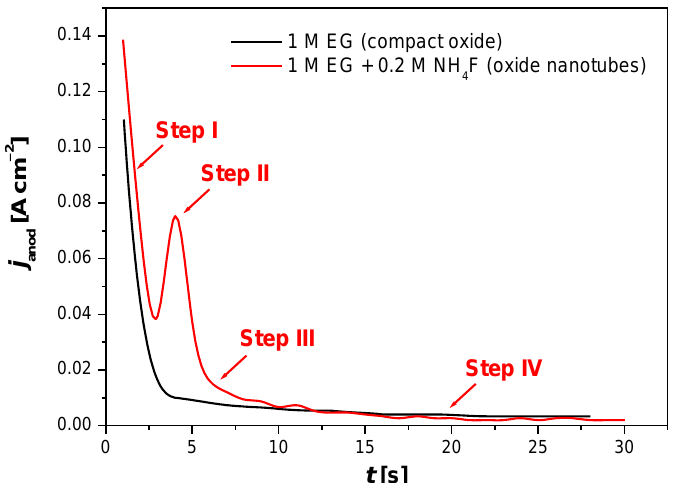
Figure 7. The curve of anodic current density ( j anod ) as a function of time ( t ), recorded during the initial anodization stage for Ti – 6Al – 7Nb electrode at 30 V for 60 min in 1 M ethylene glycol (EG) electrolyte in the presence ( — ) and absence ( — ) of 0.2 M NH 4 F.